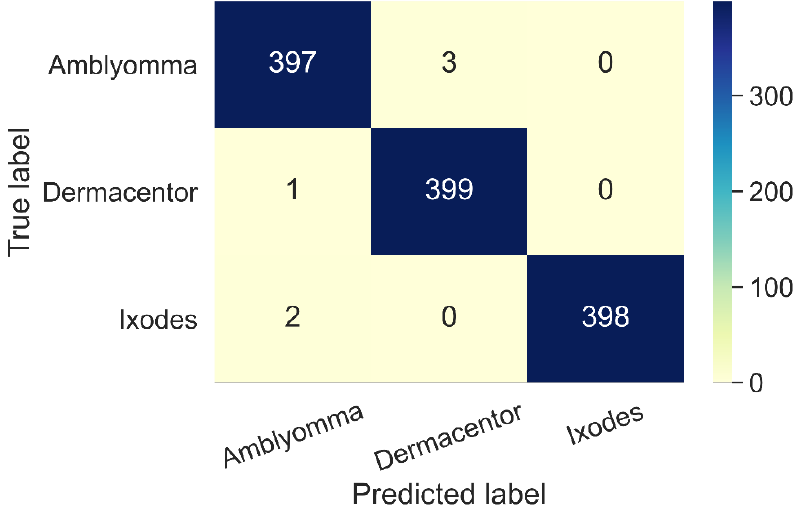
Figure 4. Example results of the confusion matrices from Inception-V3 architecture.